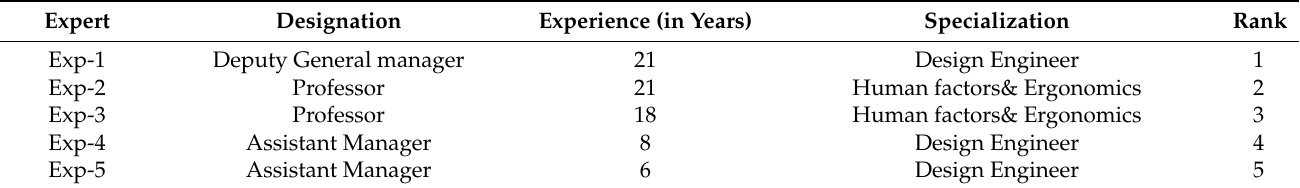
Table 4. Experts and